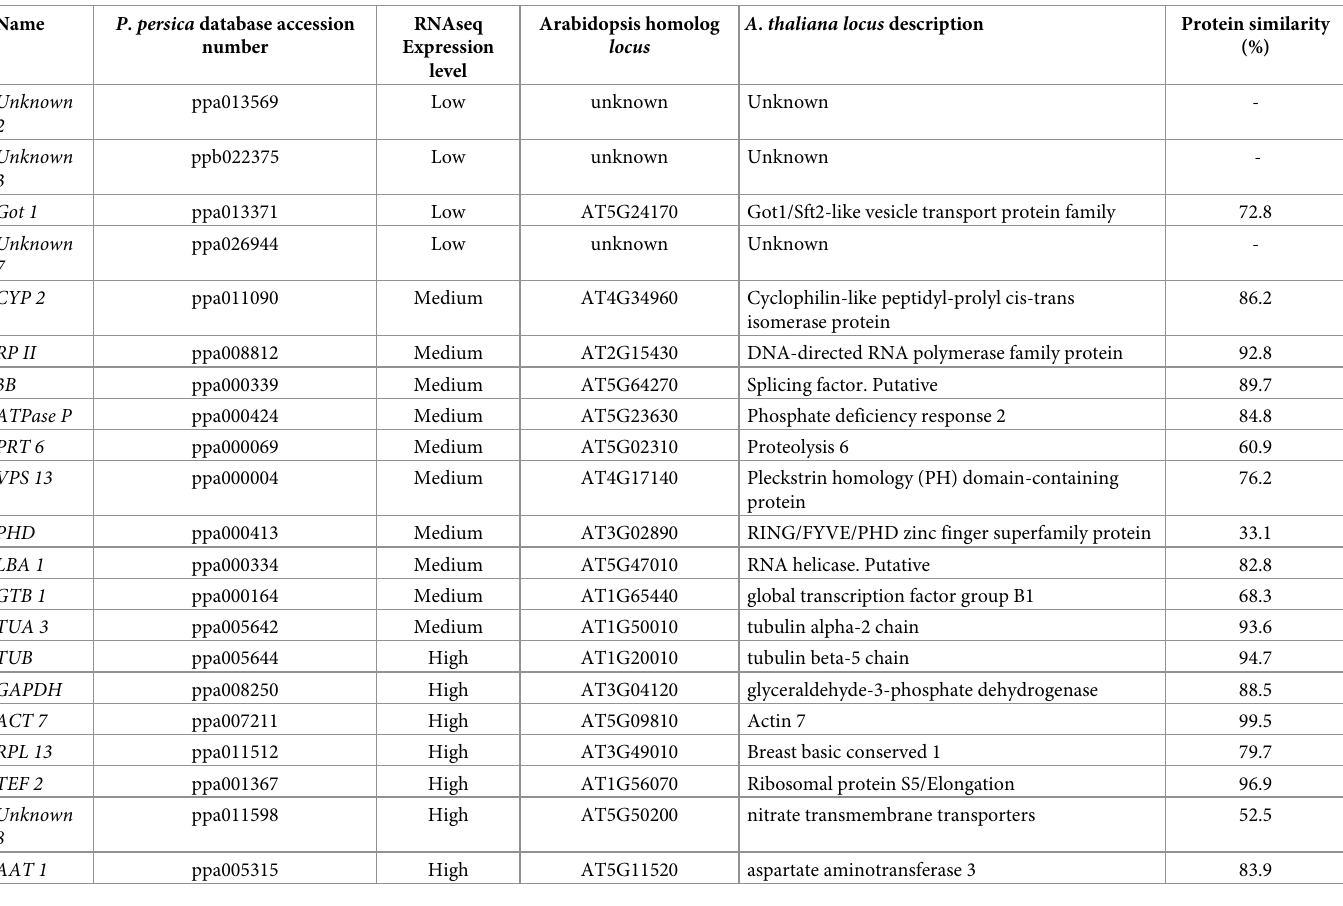
Table 1. Candidate housekeeping genes selected in this